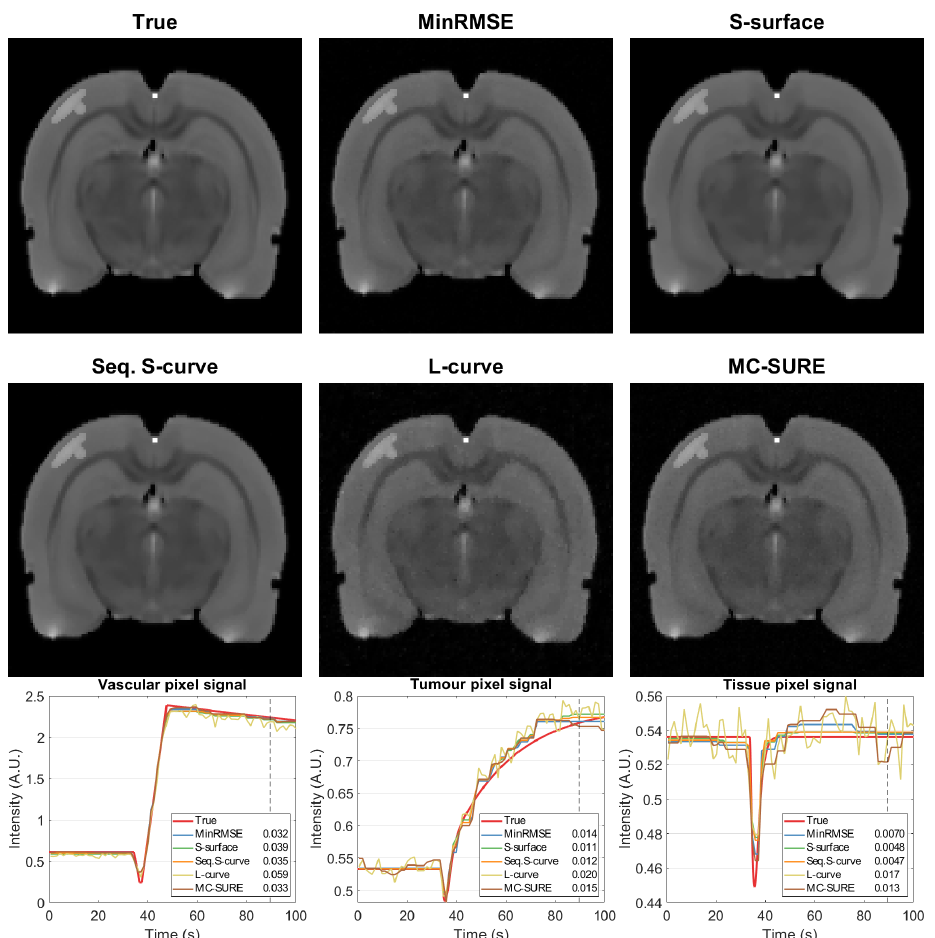
Figure 5. Top rows: Single frame images of the simulated true target and reconstructions of the simulation with noise level 5% at t ≈ 90 s (marked in the signal curves with a dashed line) with parameters chosen with different methods; minimum joint RMSE (MinRMSE), simultaneous pa- rameter selection according to joint sparsity (S-surface), sequential parameter selection according to sparsity (Seq. S-curve) and sequential parameter selection by the L-curve and MC-SURE methods. Bottom row: Single pixel signals from the vascular and tumour areas as well as healthy tissue from the right side of the cortex with the different methods compared to the phantom and RMS errors of the corresponding